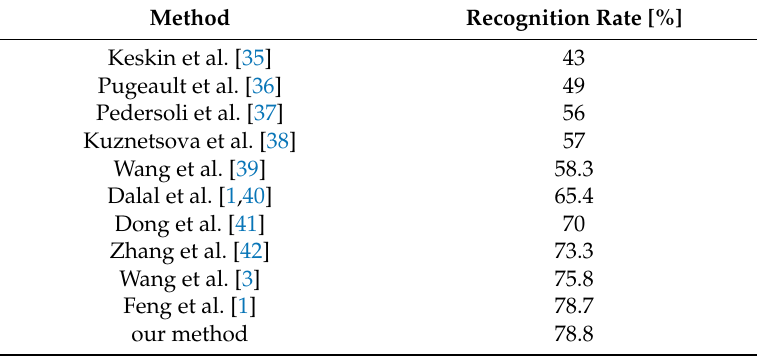
Table 7. Comparison between recognition rates of our approach using FS2 + ( E , C , L , S ) and methods found in the literature. The experiments were performed using leave-one-person-out 5-fold cross-validation